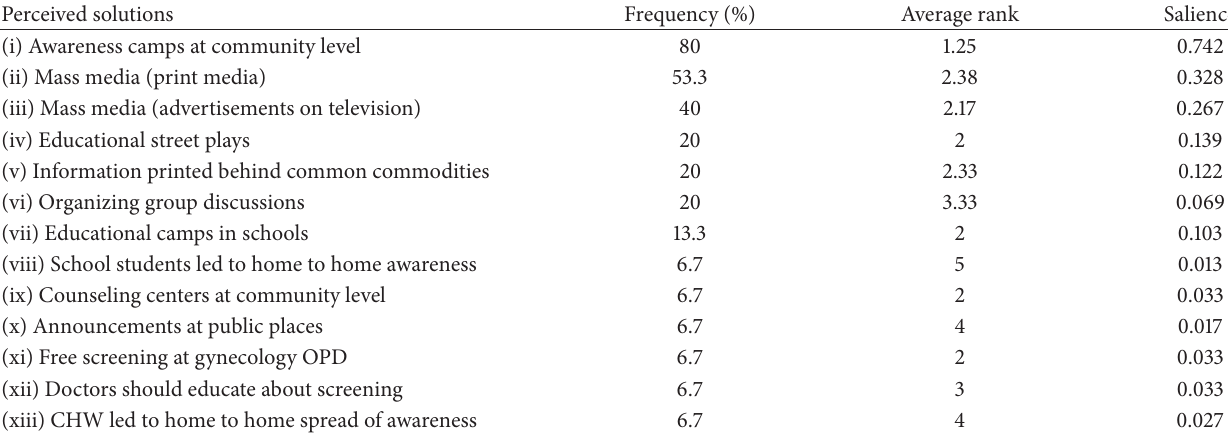
Table 8: Perceived solutions for “ information gap leading to fear of the unknown.